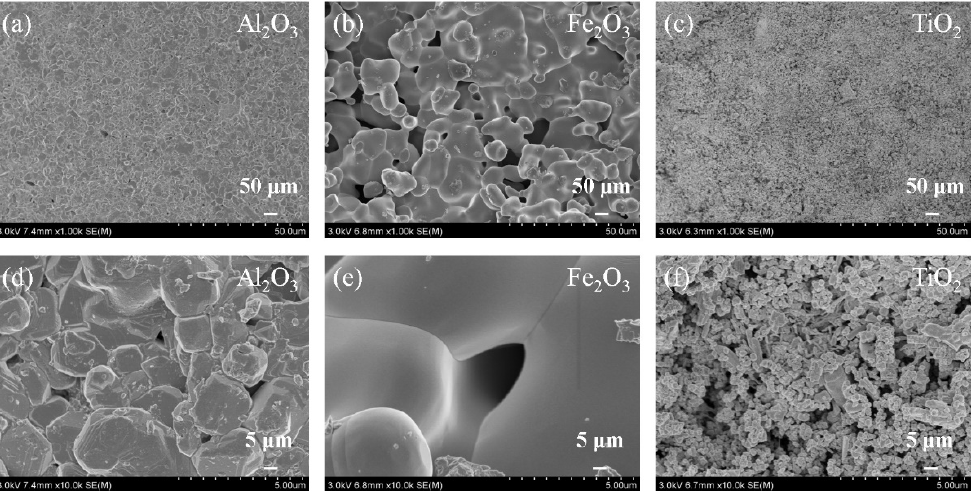
Figure 11. The scanning electron microscope (SEM) images of ( a , d ) Al 2 O 3 catalyst, ( b , e ) Fe 2 O 3 cat- alyst, and ( c , f ) TiO 2